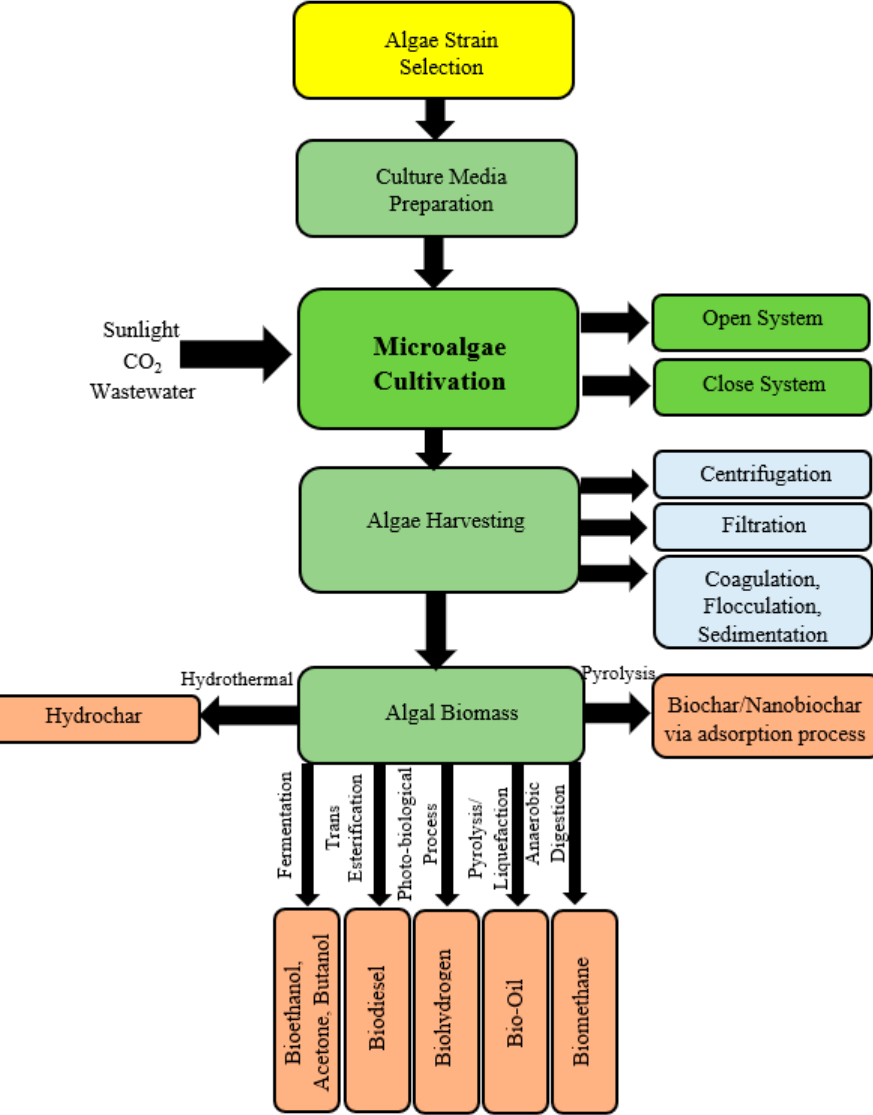
Figure 5. Technologies and avenues for application of microalgal biomass [42].